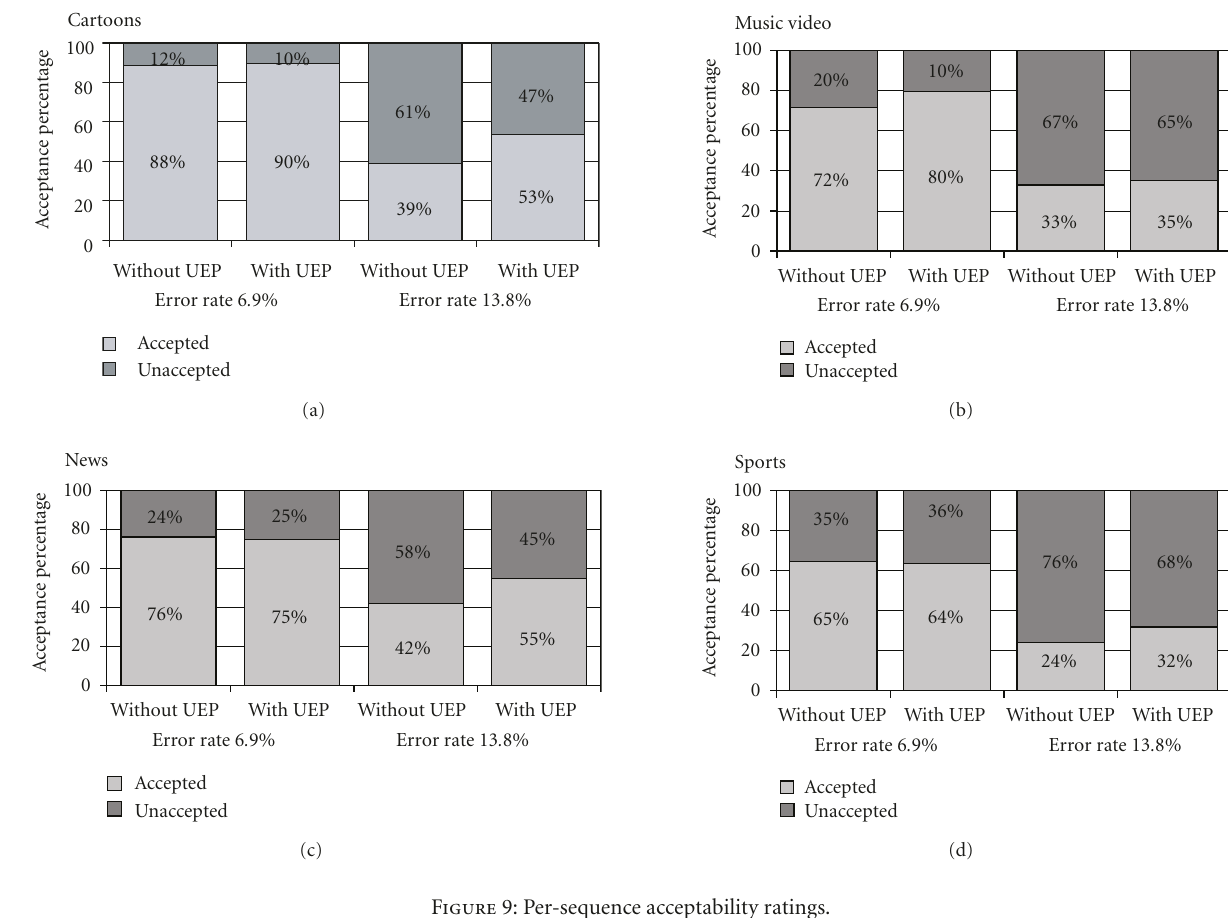
Figure 9: Per-sequence acceptability ratings.